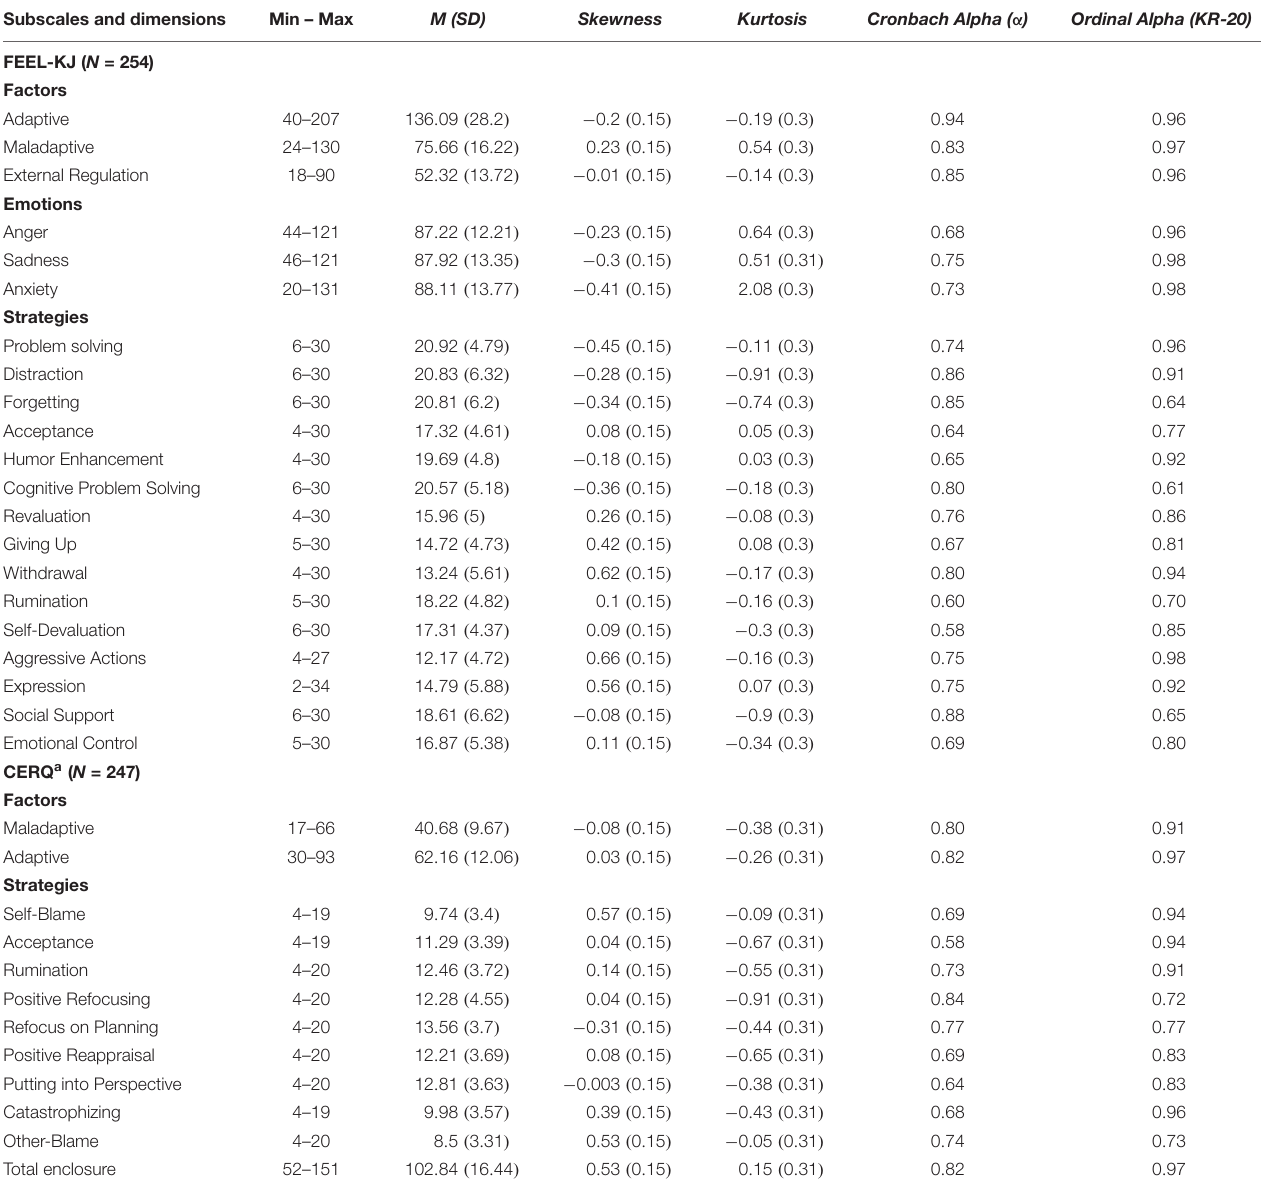
TABLE 2 | Descriptive Statistics for the FEEL-KJ and CERQ Participants’ Overall Scores. Subscales and dimensions Min – Max M (SD) Skewness Kurtosis Cronbach Alpha ( α ) Ordinal Alpha